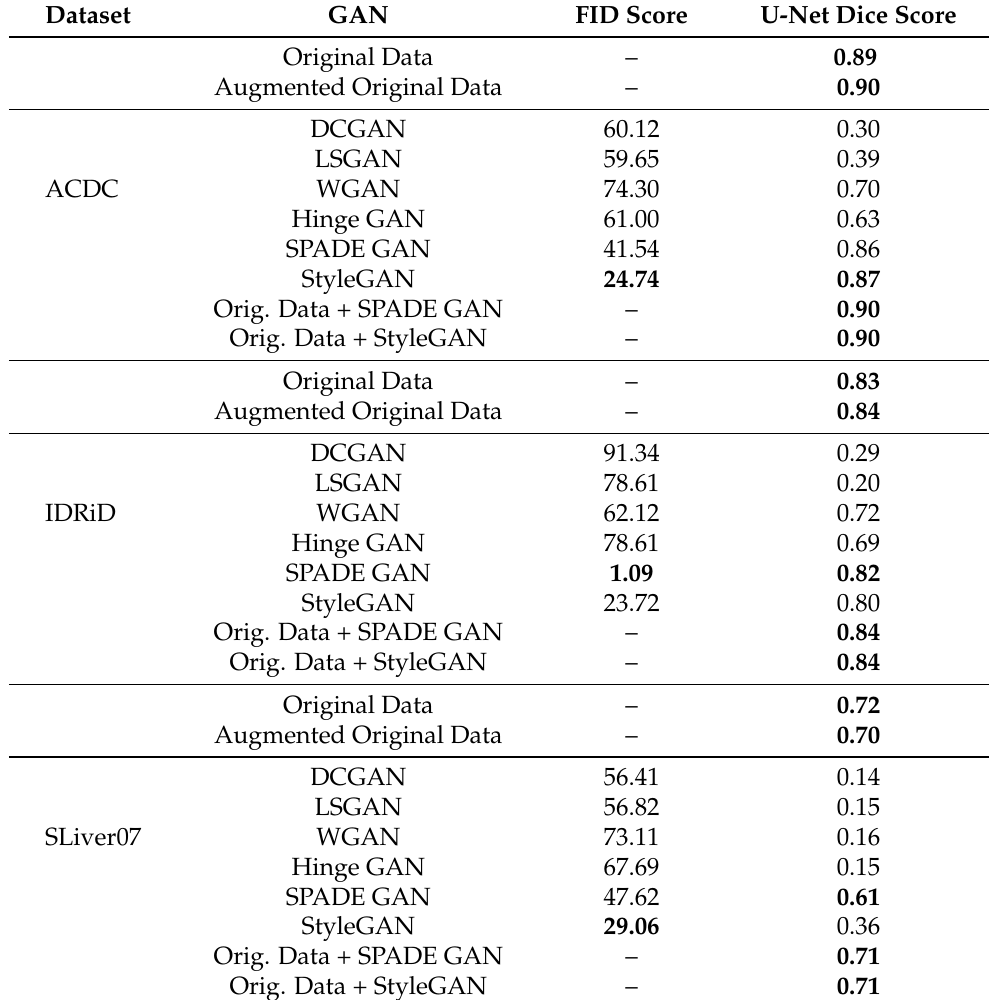
Table 2. FID and U-Net Dice score for different GANs on the ACDC, IDRiD, and SLiver07 datasets. Best score per metric for each dataset are highlighted in